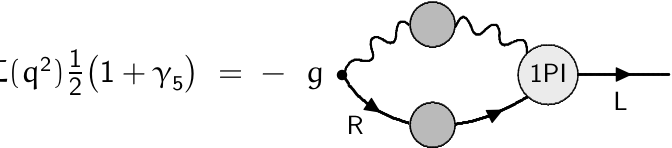
Figure 4. Self-consistent condition for the fermion self-energy Σ , with α = g 2 / ( 4 π ) . The gauge-boson and fermion propagators are fully dressed, while Σ and the vertex labelled 1PI are